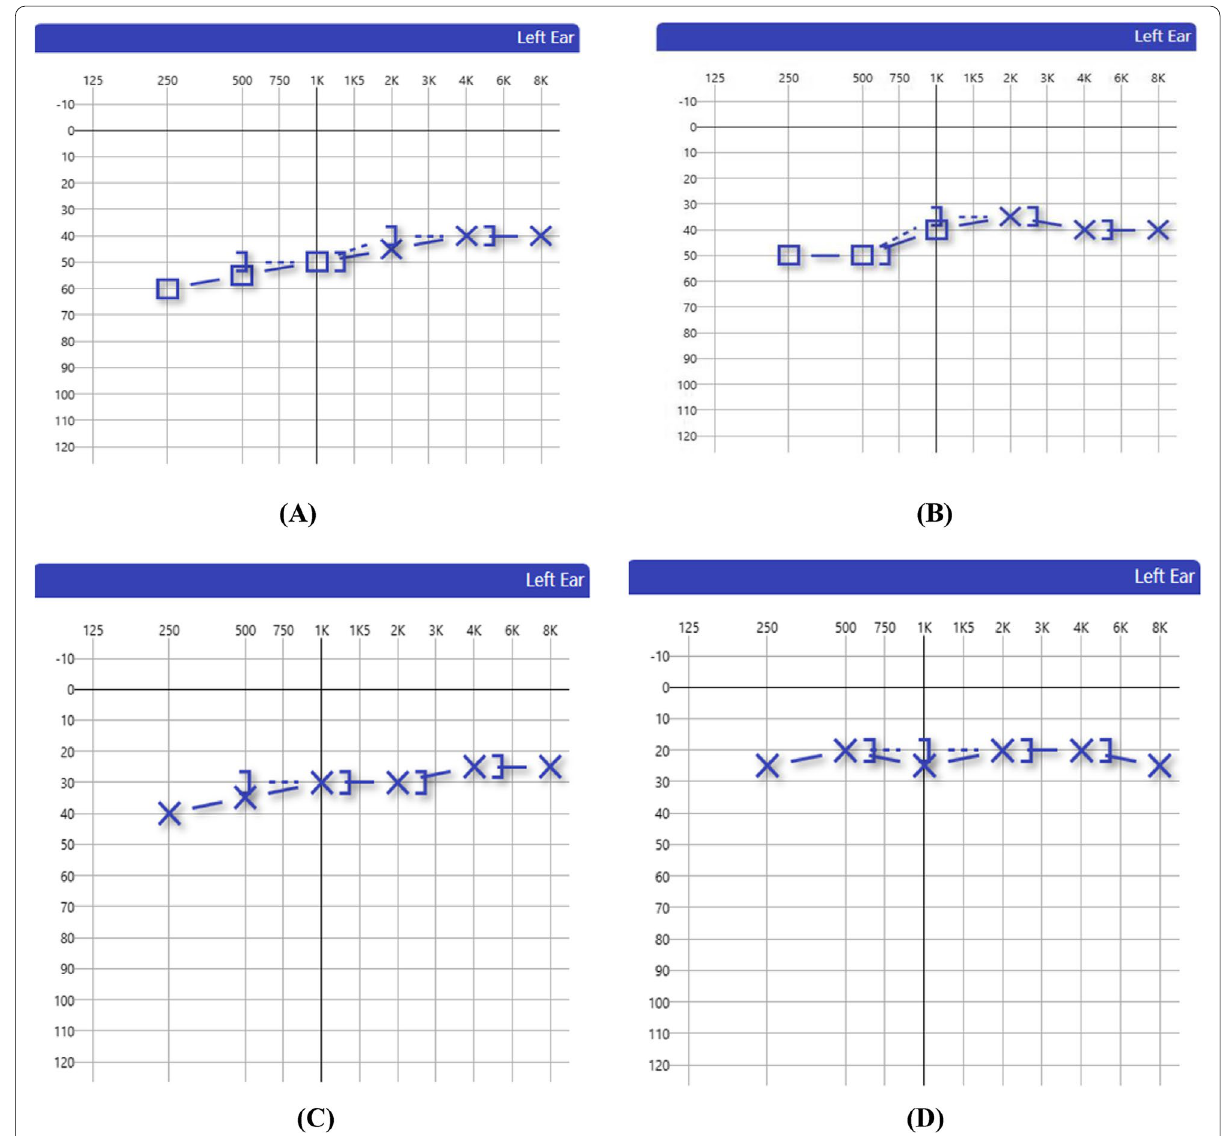
Fig. 1 Follow up audiological evaluation of a male patient aged 37 years presented with left sudden low-frequency SNHL post COVID-19 infection. A Initial presentation PTA threshold. B PTA threshold after 1-week corticosteroid treatment. C PTA threshold after 2 weeks of corticosteroid treatment. D PTA threshold after 1 month of corticosteroid